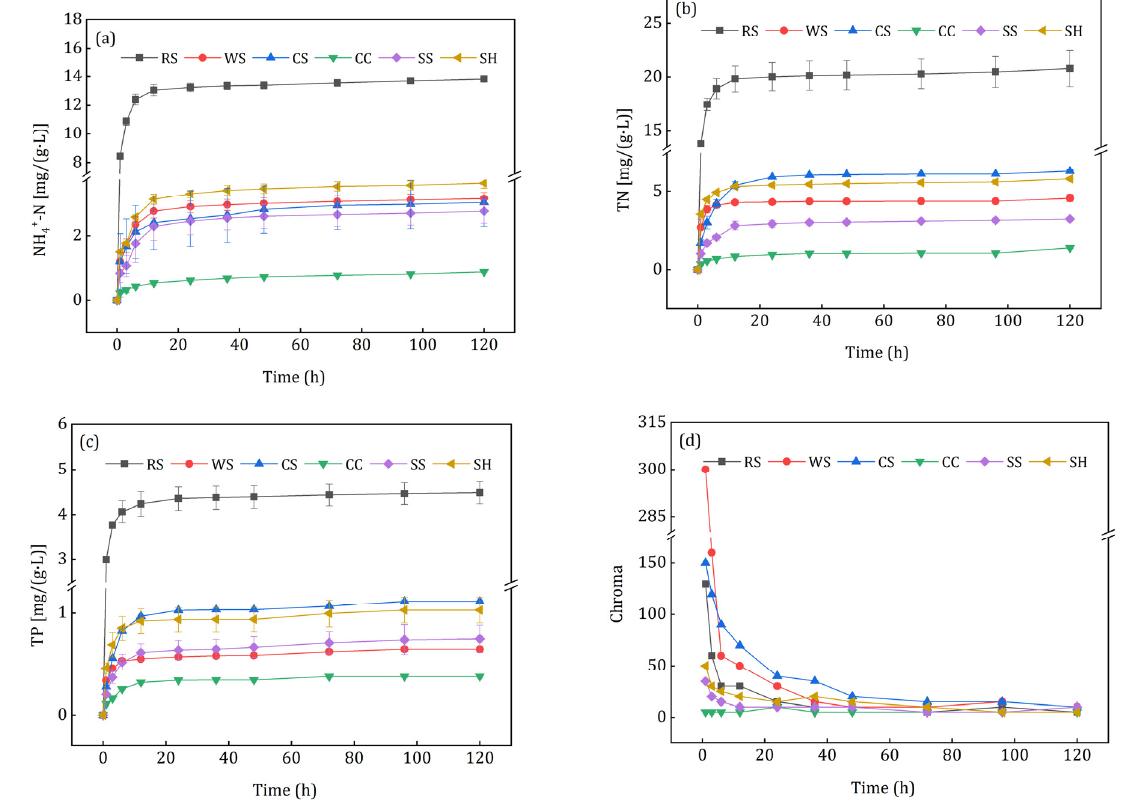
Figure 6. Release curves of secondary pollutants from the investigated agricultural wastes: ( a ) NH 4+ -N; ( b ) TN; ( c ) TP; ( d ) chroma.